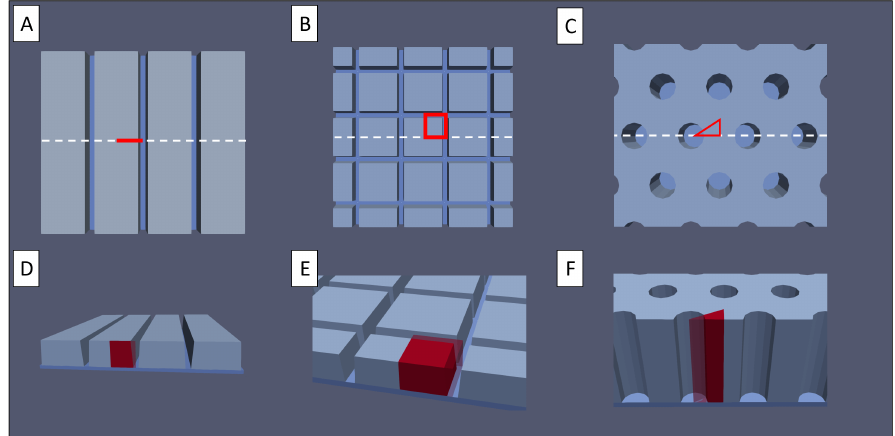
Figure 2. ( A – C ) Top view of ( A ) line structured, ( B ) grid structured, and ( C ) pinhole structured electrodes. The red marked area depicts a possible representative cross-section of the electrode. ( D – F ) Bird’s eye view of the same